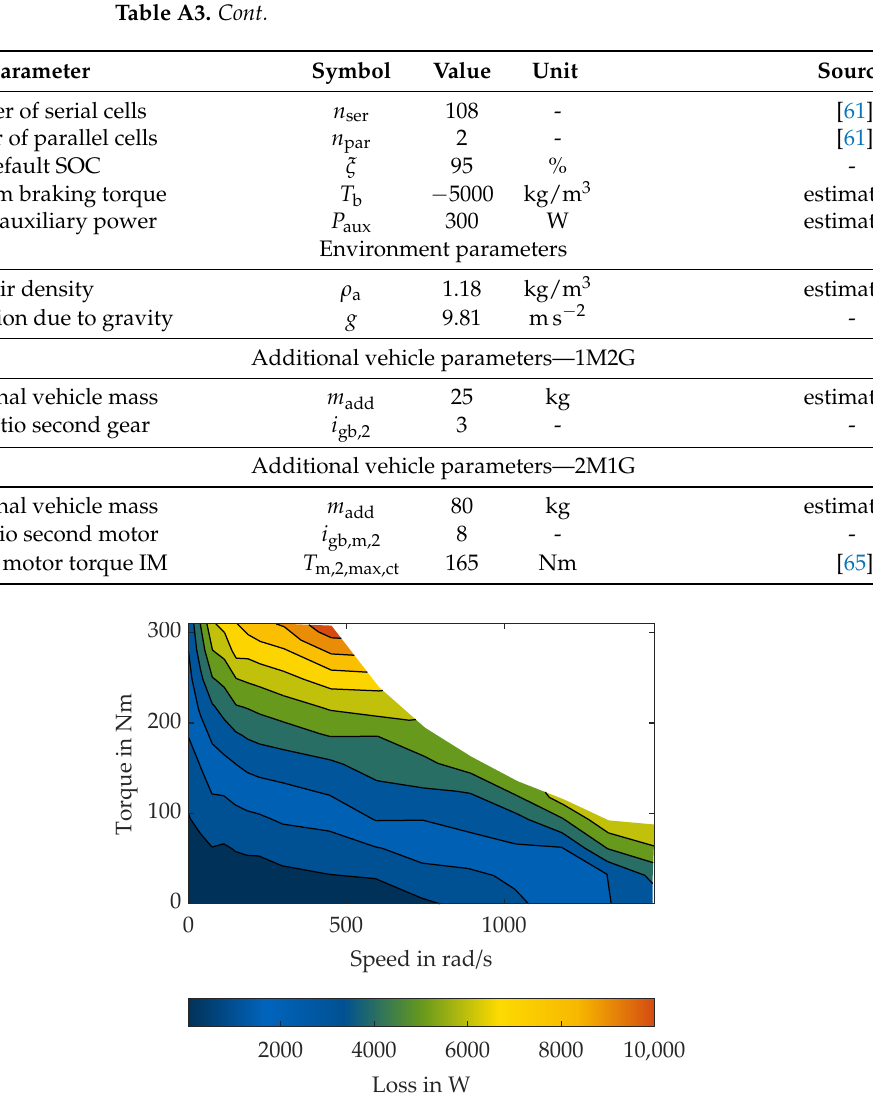
Figure A1. Contour lines of the ID.3s electric motor losses (PMSM).